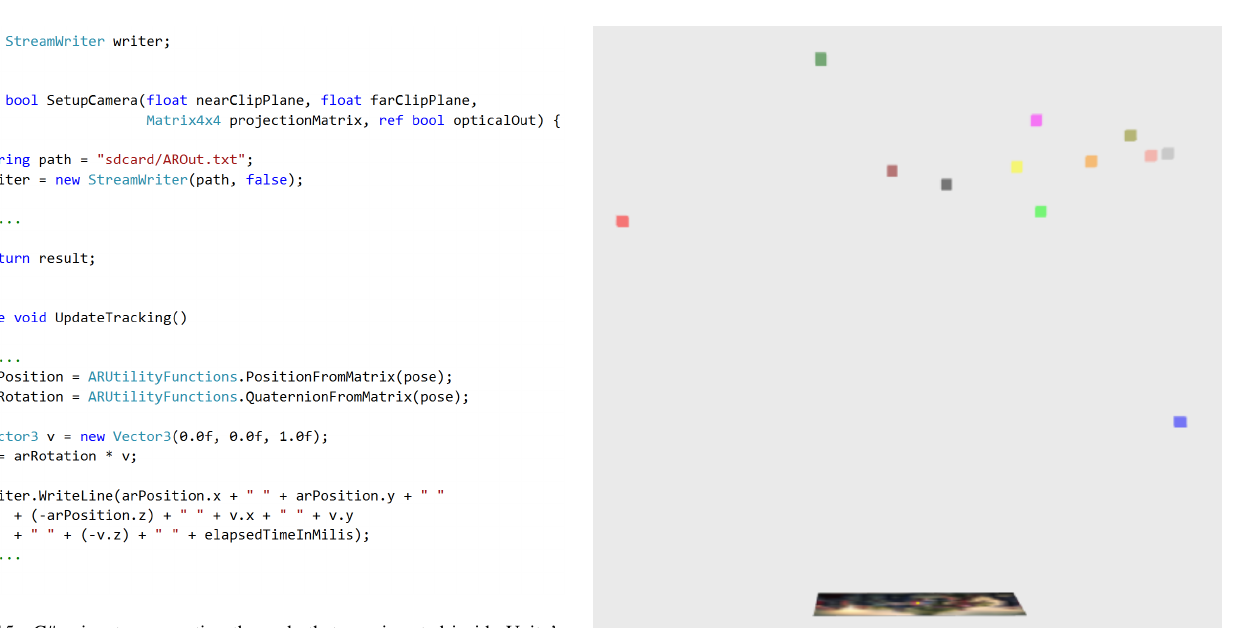
Figure 15. C# snippet representing the code that was inserted inside Unity’s script in order to capture camera’s position and orientation and then writing this information to a text file.